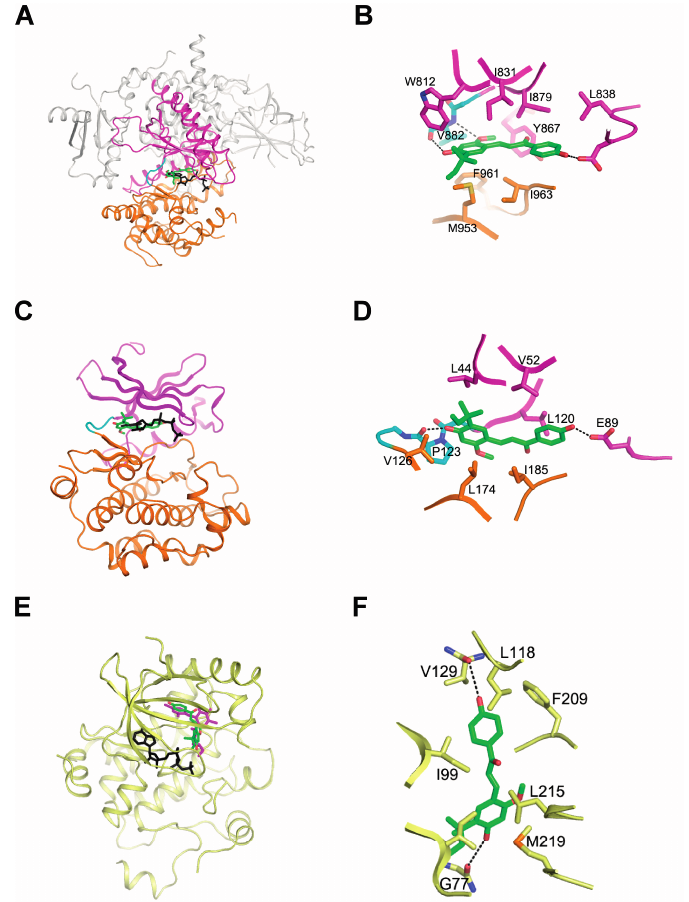
Figure 5. Hypothetical models of PI3K, B-RAF, and MEK1 in complex with LicoA. ( A ) and ( B ), Model structure of PI3K in complex with LicoA ( A ), and magnified view ( B ). The Ras-binding C2 domain, and the helical domain of PI3K are colored gray. LicoA (atomic structure) binds to the ATP binding site in the catalytic domain of PI3K and ATP (black) is overlaid for comparison; ( C ) and ( D ), Model structure of B-Raf in complex with LicoA ( C ) and magnified view ( D ). LicoA (atomic structure) binds to the ATP binding site of B-Raf and ATP (black) is overlaid for comparison. ( E ) and ( F ), Model structure of MEK1 (yellow) in complex with LicoA ( E ) and magnified view ( F ). LicoA (atomic structure) binds to the pocket adjacent to ATP’s (black) binding site. PD308088 (violet) has been overlaid on the model structure of MEK1-ATP-LicoA for comparison. In ( A ) and ( B ) the N -lobe, C -lobe, and hinge loop are colored violet, orange, and cyan, respectively. The residues involved in the interaction with LicoA are labeled and the hydrogen bonds are depicted as dotted